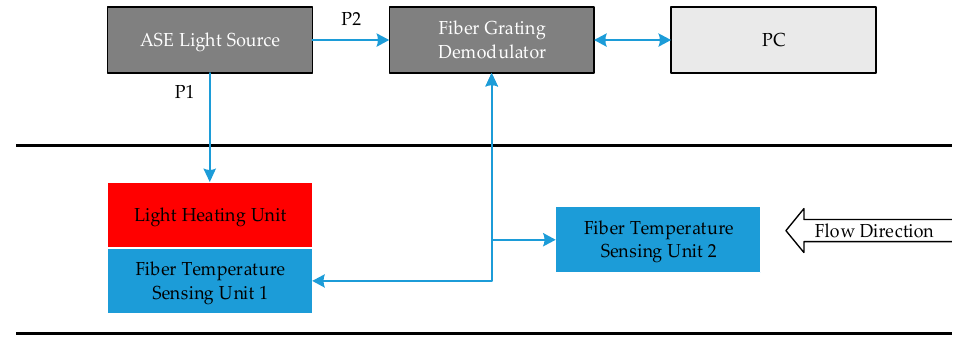
Figure 1. Overall design of the optical sensor of gas flow.